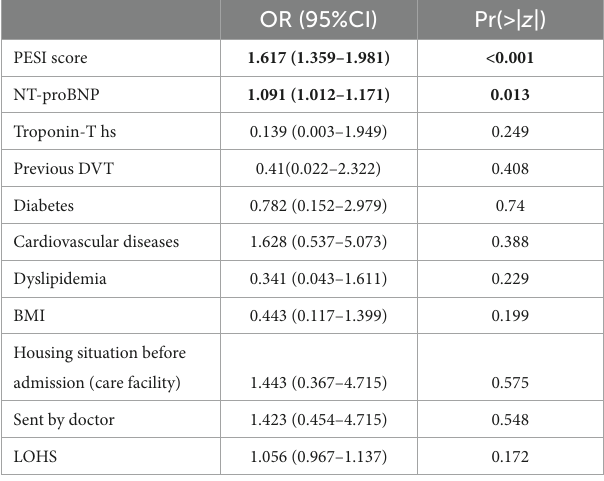
TABLE 3 Results of univariate logistic regression model for mortality (in-hospital or within 30 days) in pulmonary embolism ( n =